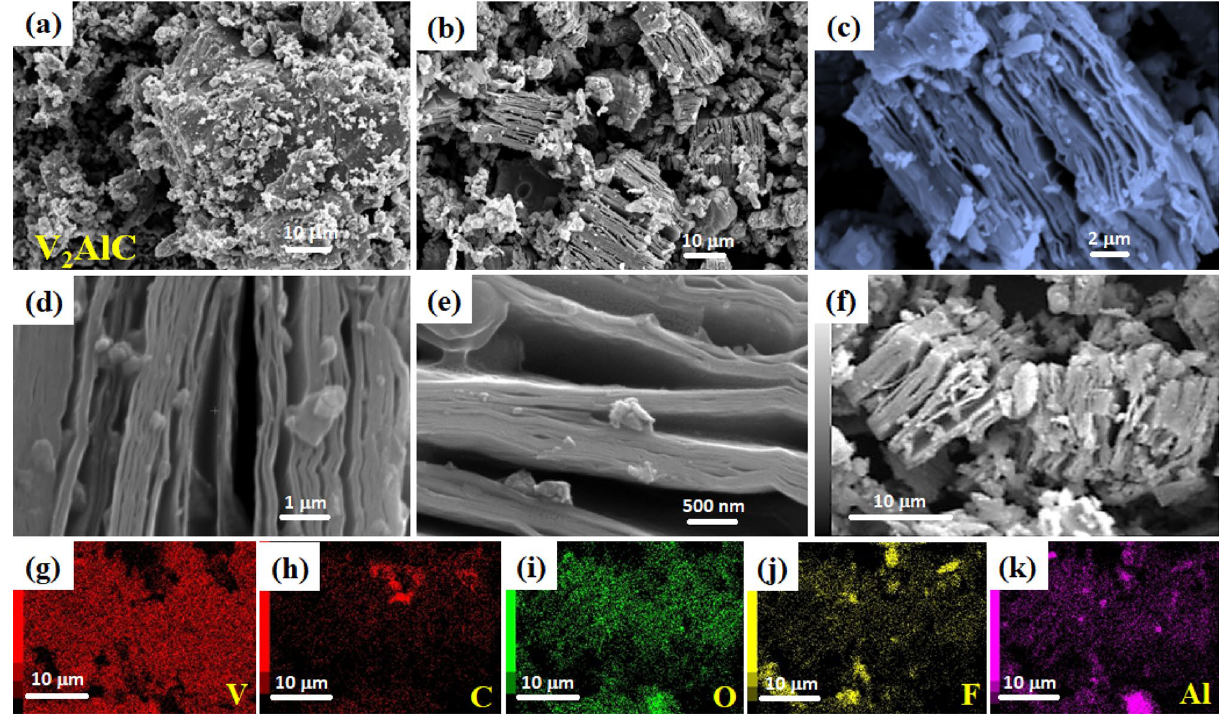
Figure 2. SEM images of V 2 AlC MAX-phase powders ( a ), V 2 CT x MXene ( b–f ), and EDX-Mapping analysis of V